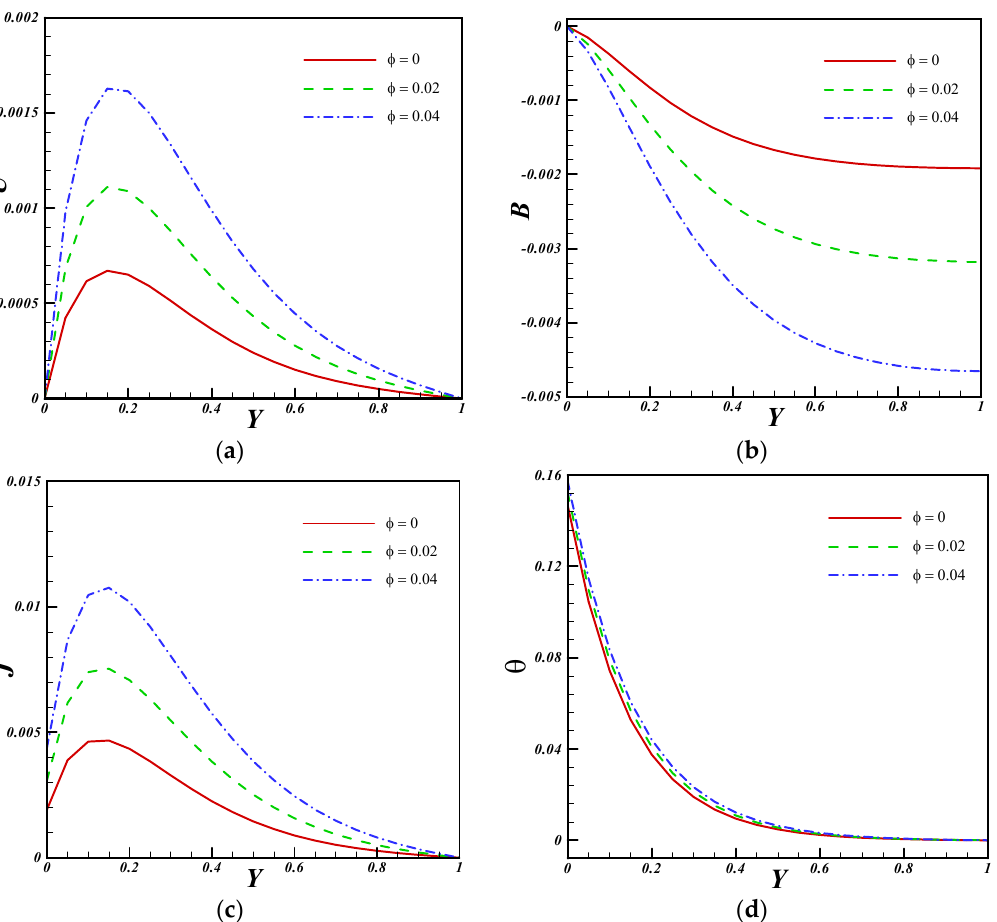
Figure 2. ( a )Effect of nanoparticle volume fraction on velocity, ( b ) induced magnetic field; ( c ) induced current density; ( d ) temperature field distributions when V 0 = 1, Ha = 5, Pm = 1, Pr = 6.8. Magnetic Prandtl number: Pm ; nanoparticle volume fraction: φ .